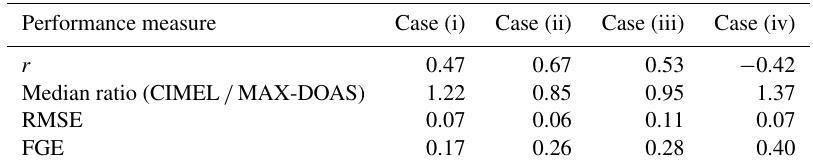
Figure 7. AOD as derived from MAX-DOAS (black curve) and CIMEL at 440nm and 500nm (green and blue curve, respectively). The grey and the red square markers represent the Ångström exponent derived from 400 and 870nm and the lidar-derived AOD, respectively. The dashed black curves represent the MAX-DOAS AOD uncertainties. The scatterplots between hourly AOD calculated from MAX-DOAS measurements and hourly AOD from CIMEL at 500nm are shown in the internal panels; the red points correspond to measurements after 13:00UTC. Accordingly, y 0 is the linear-regression equation with all the data points included, and y 1 is the linear-regression equation when the data points after 13:00UTC have been excluded. The smaller blue points are the raw data points. The vertical dashed red line separates the measurement data before and after 13:00UTC. Table 6. Quantitative performance statistics of MAX-DOAS AOD calculations (BOREAS algorithm) at 477nm compared to CIMEL mea- surements at